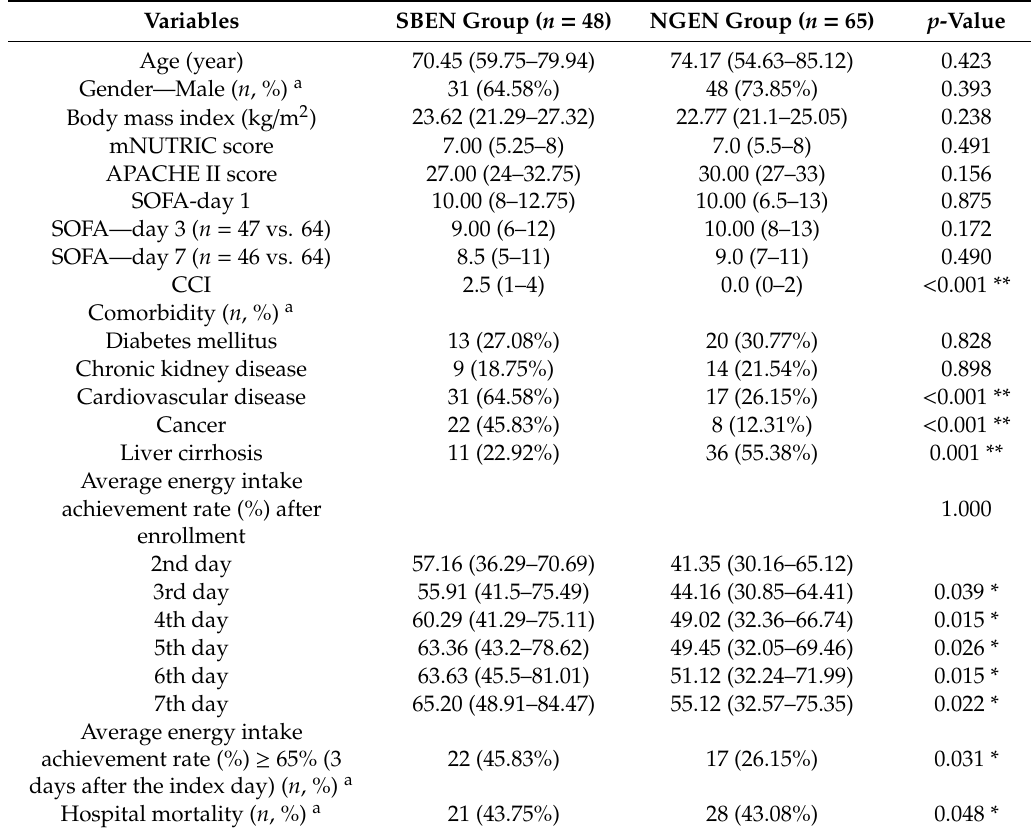
Table 1. Demographic characteristics, severity scores, comorbidities, and clinical outcomes for all malnourished patients in the intensive care unit